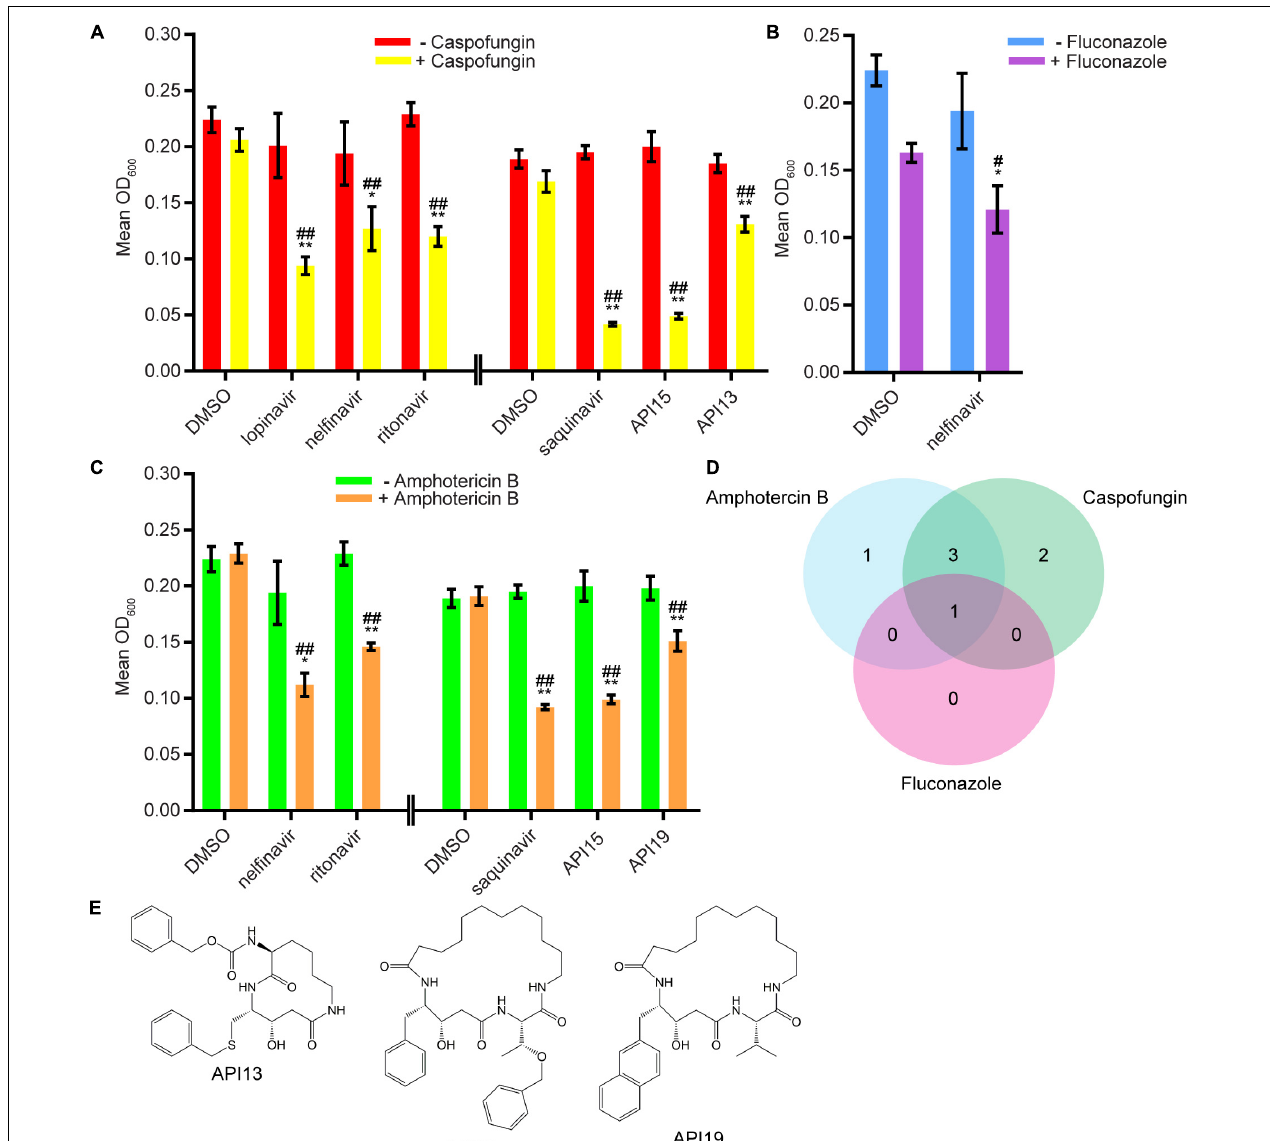
FIGURE 3 | Seven aspartyl protease inhibitors were capable of inhibiting biofilm formation in combination with one or more of the three antifungal agents tested. (A) Statistically significant hits from the combination Sustained Inhibition Biofilm Assays with caspofungin. For each compound, the wells with caspofungin (+caspofungin) are indicated in yellow and the wells without caspofungin (–caspofungin) are indicated in red. (B) Statistically significant hit from the combination Sustained Inhibition Biofilm Assays with fluconazole. For each compound, the wells with fluconazole (+fluconazole) are indicated in purple and the wells without fluconazole (–fluconazole) are indicated in blue. (C) Statistically significant hits from the combination Sustained Inhibition Biofilm Assays with amphotericin B. For each compound, the wells with amphotericin B (+amphotericin B) are indicated in orange and the wells without amphotericin B (–amphotericin B) are indicated in green. For panels a–c, mean OD 600 readings with standard deviations are shown; significant differences from the compound without antifungal agent control (e.g., lopinavir, – caspofungin), as determined by Welch’s t -test (two-tailed, assuming unequal variance) with the Bonferroni Correction, are indicated for α = 0.05 (*) and α = 0.01 (**). Significant differences from the antifungal agent without compound control (e.g., DMSO, +caspofungin), as determined by Welch’s t -test (two-tailed, assuming unequal variance) with the Bonferroni Correction, are indicated for α = 0.05 (#) and α = 0.01 (##). Data from separate plates are separated by two vertical lines on the x -axis; the DMSO solvent control is shown for each plate. (D) Venn diagram illustrating the degree of overlap between the combination aspartyl protease inhibitor Sustained Inhibition Biofilm Assay screens with amphotericin B, caspofungin, or fluconazole. (E) Structure of the aspartyl protease inhibitors API13, API15, and